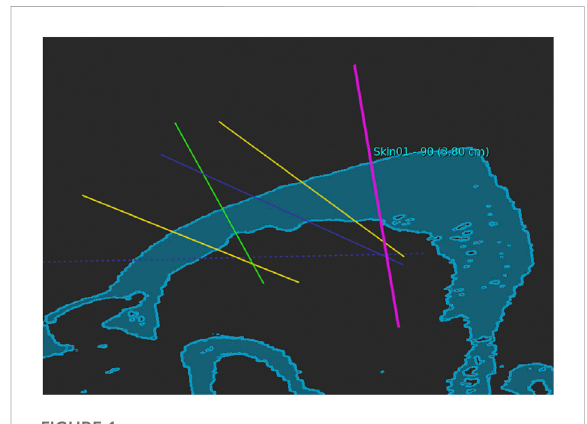
FIGURE 1 Planned trajectories for depth electrodes in a pig